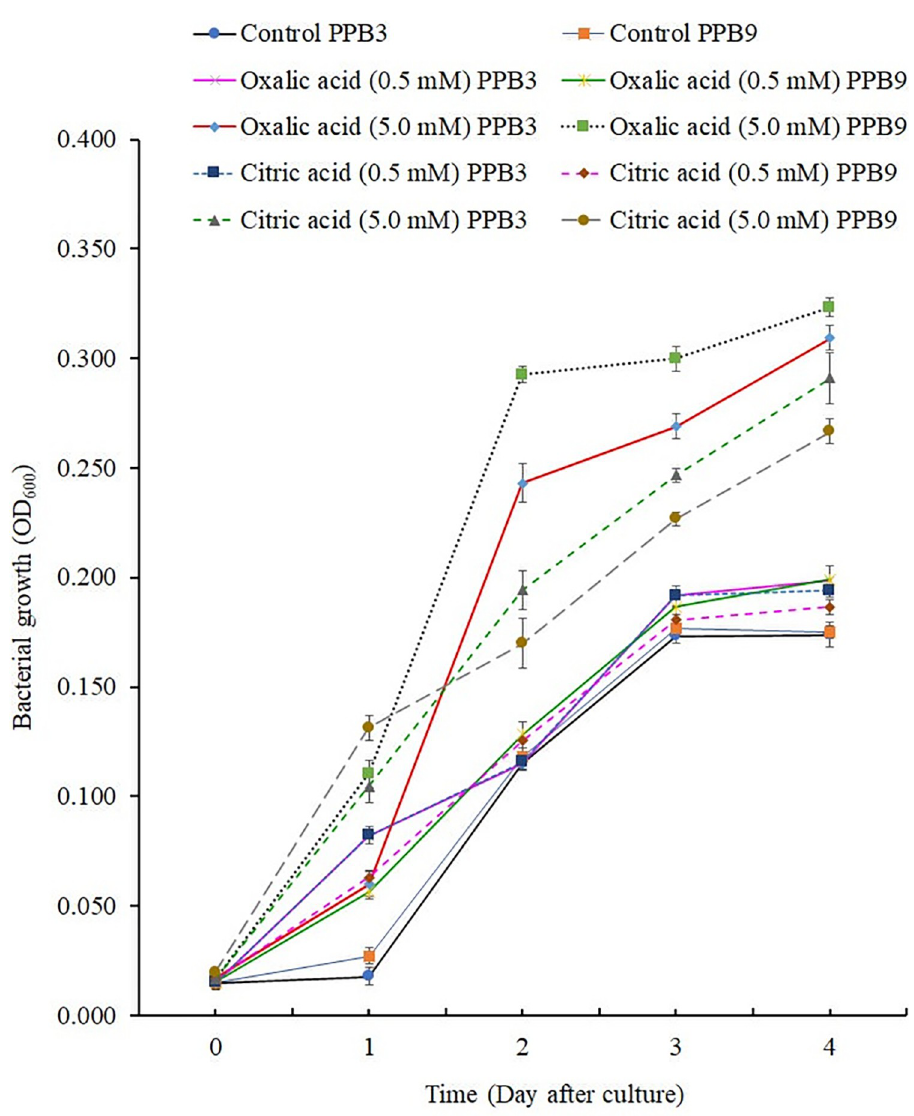
Fig 1. Growth of Stenotrophomonas maltophilia PPB3 (PPB3) and Bacillus subtilis PPB9 (PPB9) on water-yeast broths (WYBs), supplemented with either oxalic acid or citric acid as a carbon source at concentrations of 0.5 mM and 5.0 mM. Borosilicate glass test tubes containing 20 ml WYB supplemented with oxalic acid at concentrations of 0.5 mM [Oxalic acid (0.5 mM) PPB3; Oxalic acid (0.5 mM) PPB9], and 5.0 mM [Oxalic acid (5.0 mM) PPB3; Oxalic acid (5.0 mM) PPB9] were prepared in triplicate for each culture. Another set of borosilicate glass test tubes containing 20 ml WYB supplemented with citric acid at concentrations of 0.5 mM [Citric acid (0.5 mM) PPB3; Citric acid (0.5 mM) PPB9], and 5.0 mM [Citric acid (5.0 mM) PPB3; Citric acid (5.0 mM) PPB9] were prepared in triplicate for each culture. In addition, WYBs without organic acid addition were included as controls (Control PPB3 and Control PPB9). The broths were inoculated with pre-grown bacterial inocula and incubated on a shaker at 120 rpm at 28˚C for four days. The optical density of the cultures was measured daily at 0-, 1-, 2-, 3-, and 4-days post-inoculation. Each point in the line graph represents the mean value of three replicates ( n = 3 ). Vertical lines denote the standard errors. at each time point, starting from 2 to 4-day post-inoculation. Between the two carbon sources at 5.0 mM concentration, PPB3 and PPB9 showed significantly higher growth in broth supple- mented with oxalic acid than citric acid. In oxalic acid at a 5.0 mM concentration, B . subtilis PPB9 showed significantly higher cell densities than S . maltophilia PPB3 on day 2 and 3, while